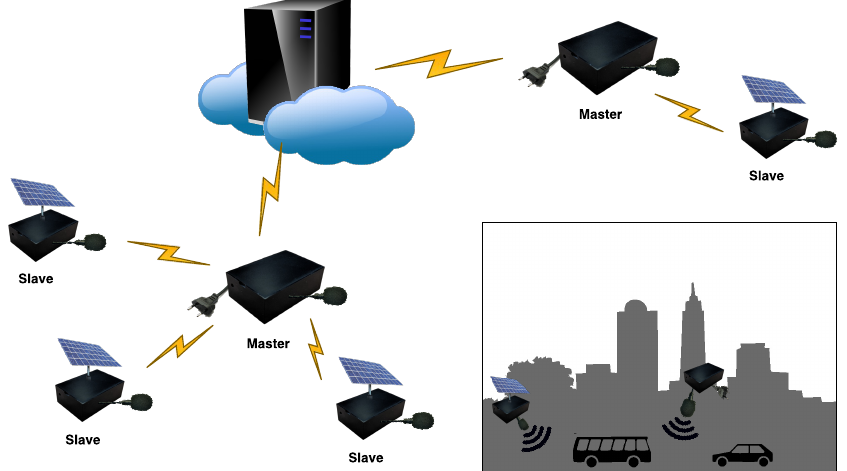
Figure 1. Scheme of an hybrid WASN architecture using Hi-Cap master sensor nodes and Lo-Cap slave sensor nodes, with a distributed